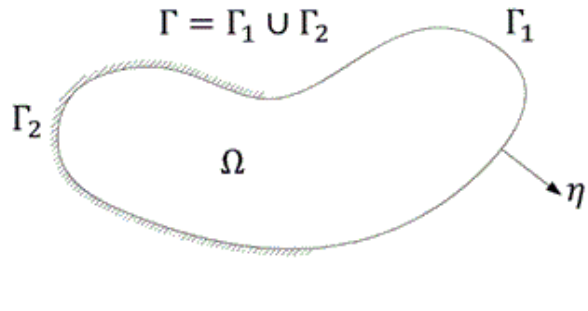
Figure 2 – Domain, boundaries and outward